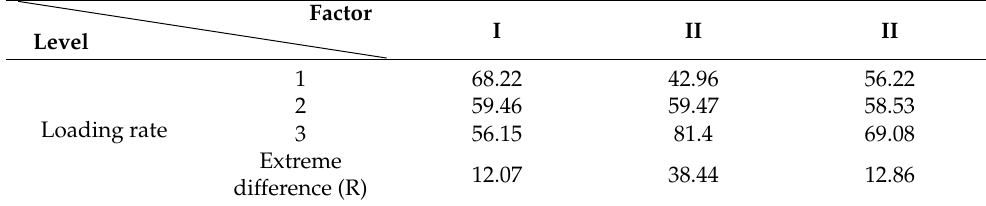
Table 5. Loading rate at every level and between levels for each